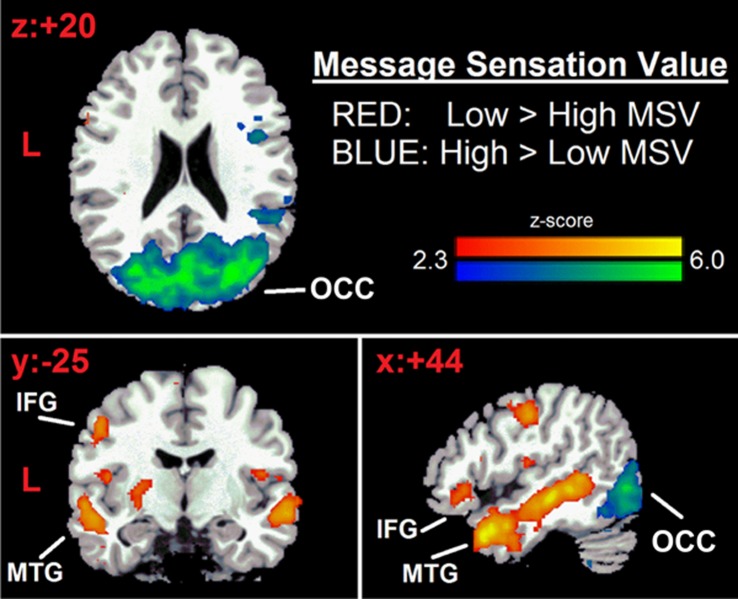
Brain response to safe-sex video messages.Middle temporal gyrus (MTG) and inferior frontal gyri (IFG) (red) have increased response for Low MSV>High MSV ads. Occipital cortex (OCC) (blue) has increased response for High MSV>Low MSV ads. Statistical maps are displayed over the Montreal Neurological Institute (MNI) brain template and thresholded at Z = 2.3, cluster-corrected for multiple comparisons at p<0.05. Coordinates converted to Talairach space [45].